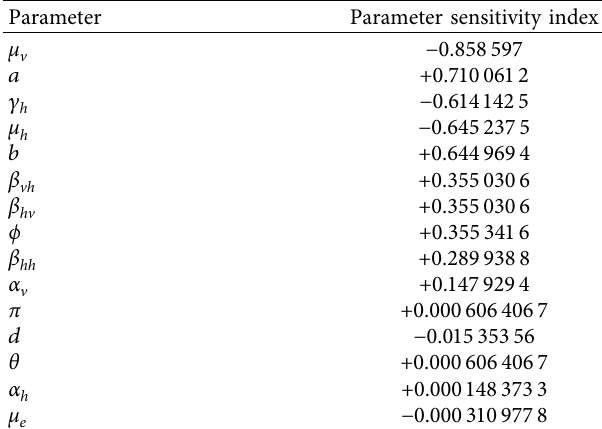
Table 4: The global sensitivity analysis indicates the sensitivity of the basic reproduction number, R , to the model parameters. Bars 0 indicate partial rank correlation coefficients (PRCCs). It illustrates the contribution of parameters to variability or uncertainty in the ) model outputs ( R 0